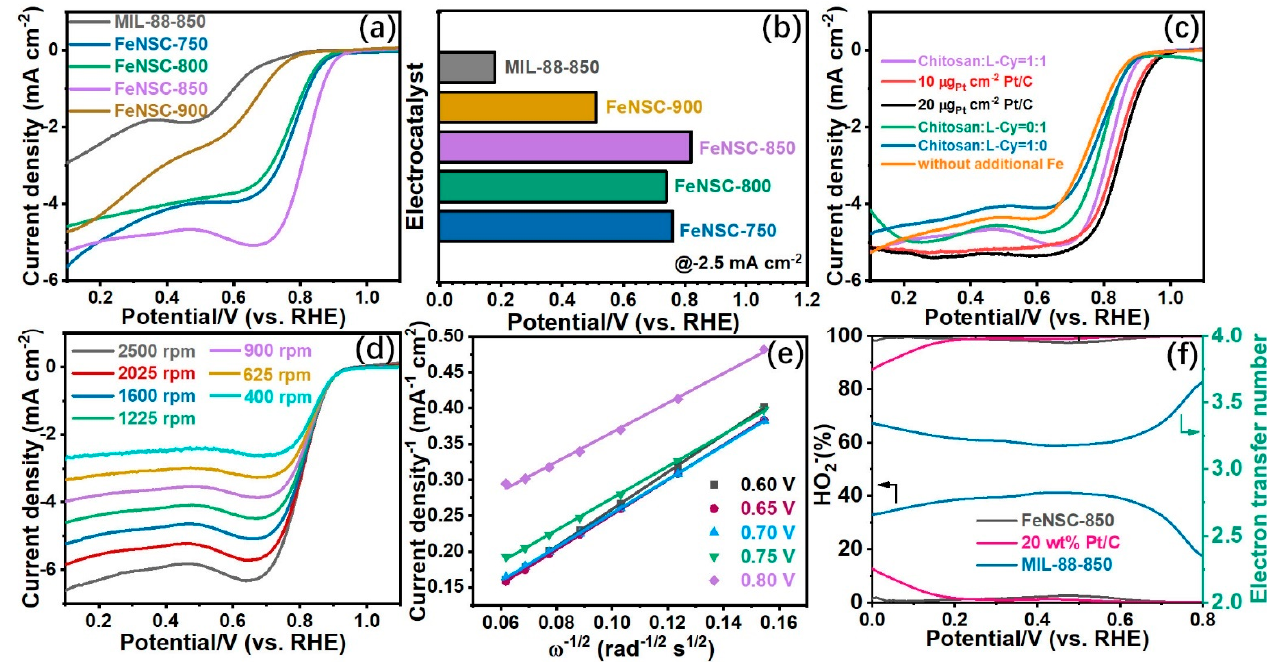
Figure 5. ( a ) Linear sweep voltammogram (LSV) curves of FeNSCs pyrolyzed with various heating ‐ temperature from 750 to 900 °C and MIL ‐ 88 carbonized at 850 °C at 1600 rpm; ( b ) potentials of FeNSC ‐ T (T = 750 − 900 °C) and MIL ‐ 88 ‐ 850 at − 2.5 mA cm − 2 based on the LSV data from ( a ); ( c ) LSV curves of as ‐ prepared electrocatalysts with different mass ratio of chitosan and L ‐ Cy, the electrocatalyst without additional Fe salt with mass ratio of chitosan and L ‐ Cy as 1:1, and commercial Pt/C at loading of 10 and 20 μ g Pt cm − 2 with a scanning rate of 5 mV s − 1 ; ( d ) LSV curves of FeNSC ‐ 850 with various rotation rates from 400 to 2500 rpm; ( e ) Koutecky ‐ Levich (K ‐ L) plots of FeNSC ‐ 850 based on the data from ( d ); and ( f ) HO 2 ‐ % and electron transfer number of FeNSC ‐ 850, MIL ‐ 88 ‐ 850, and 20 wt% Pt/C with Pt loading of 20 μ g Pt cm − 2 in 0.1 M KOH electrolyte.